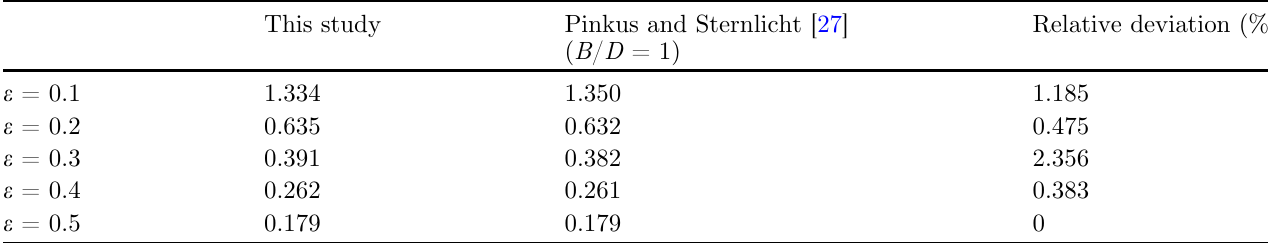
Table 3. Comparisons of Sommerfeld numbers with Pinkus and Sternlicht [27]. This study Pinkus and Sternlicht